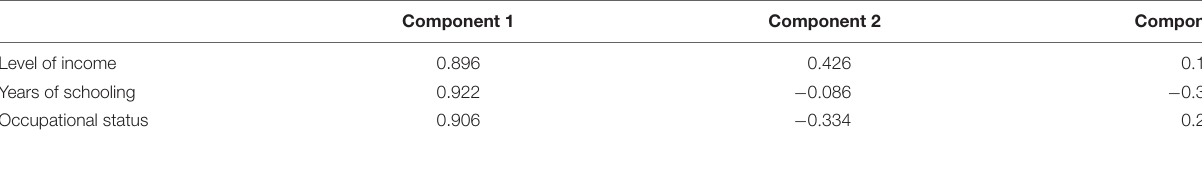
TABLE A2 | Correlations of variables with the principal components for the SES Index.